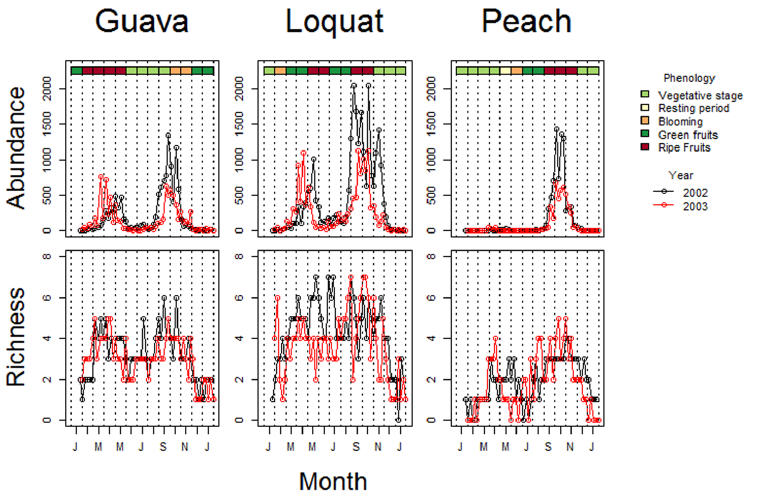
Fig 3. Total abundance and species richness data of fruit flies in relation to time and fruit tree phenology for samples collected during two years (2002 – 2003) in an experimental station in Monte Alegre do Sul, state of S ã o Paulo,